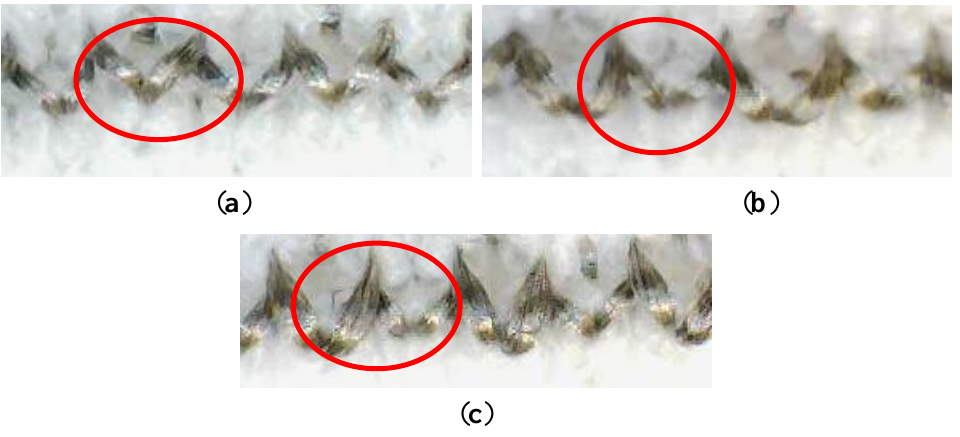
Figure 6. Magnified images of conductive loops in part of a single knitted course ( a ) Sample with 20cN conductive yarn input tension; ( b ) Sample with 10 cN conductive yarn input tension; ( c ) Sample with 5 cN conductive yarn input